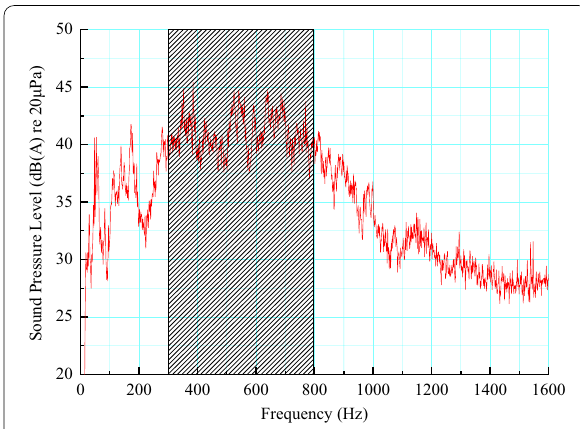
Figure 7 Frequency spectrum of passenger room noise above